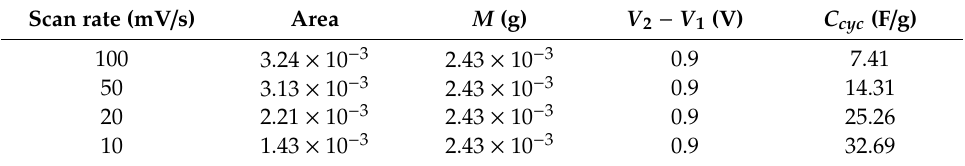
Table 5. Calculated specific capacitance from the CV plot at different scan rates.